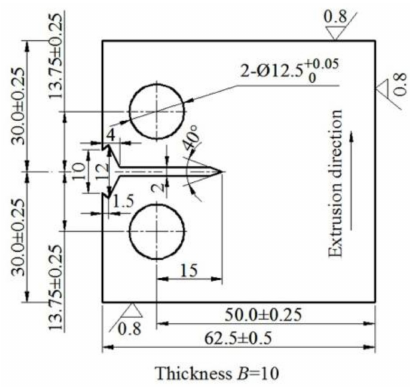
Figure 2. Compact tension specimen geometry for the FCGR studies (mm).